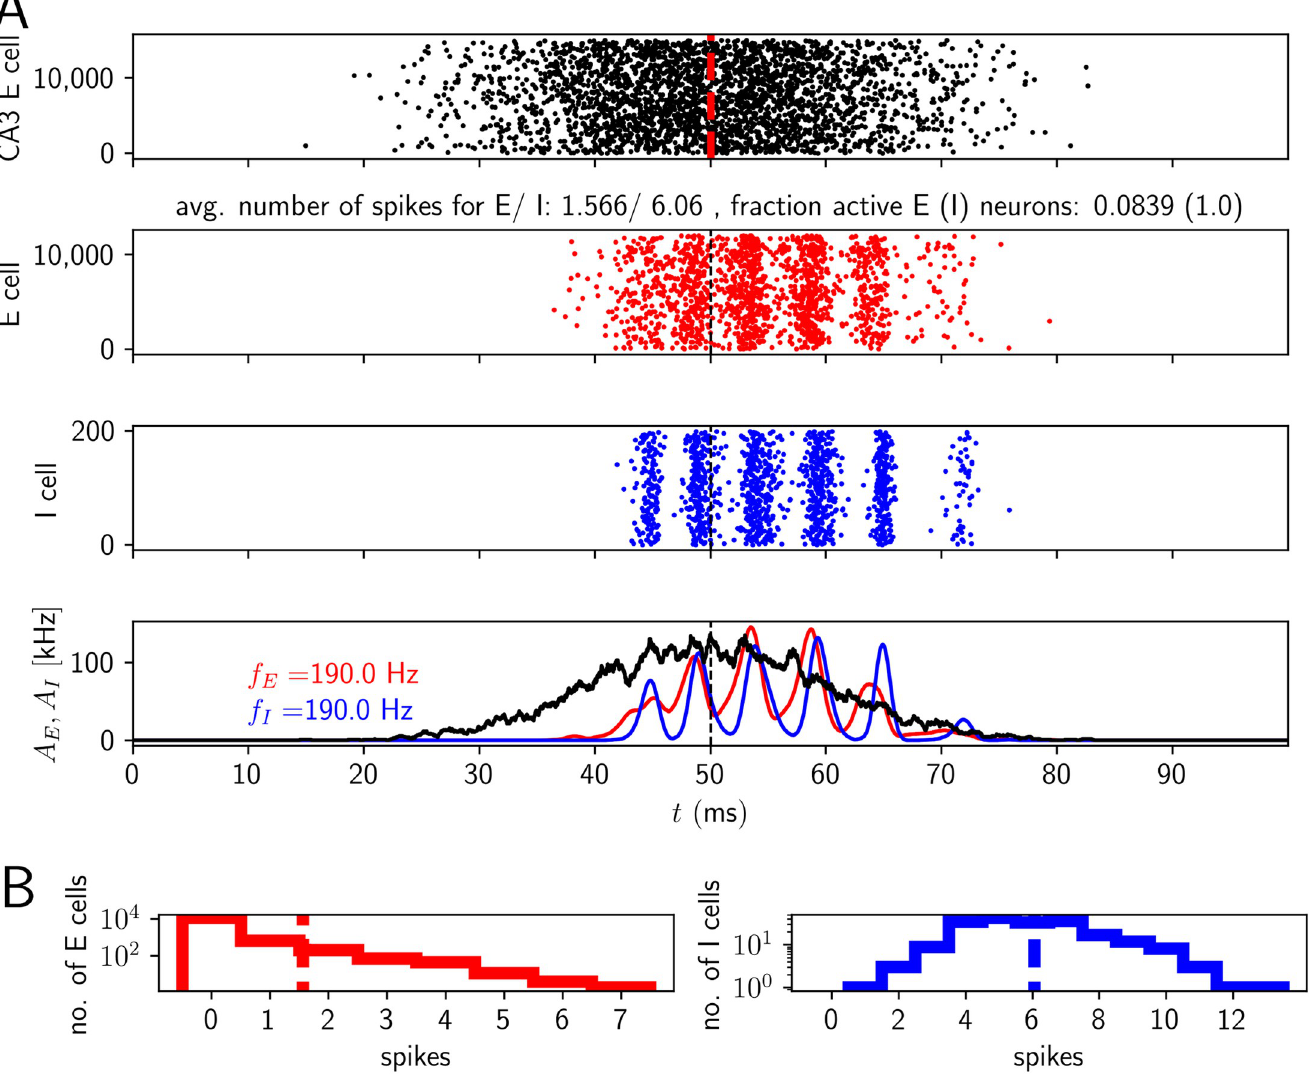
Fig 7. Activity in a network with nonlinear dendritic excitation of E cells (model 3). E and I populations spike at ripple frequency, active E cells typically contribute one or two spikes to an event. A, upper subpanel: Spikes generated by CA3. Middle: spike rastergrams of the CA1 E and I cells (red and blue). Lower: population rates (red: population of E cells, blue: population of I cells, black: population of CA3 cells). B: Histograms of spike counts. Parameter values as in Fig 8, ( σ , μ ) = (0.75, 0.0). Fraction of active E/I cells ( q , q ): 0.084, 1. Number of spikes per spiking E/I cell ( C E I